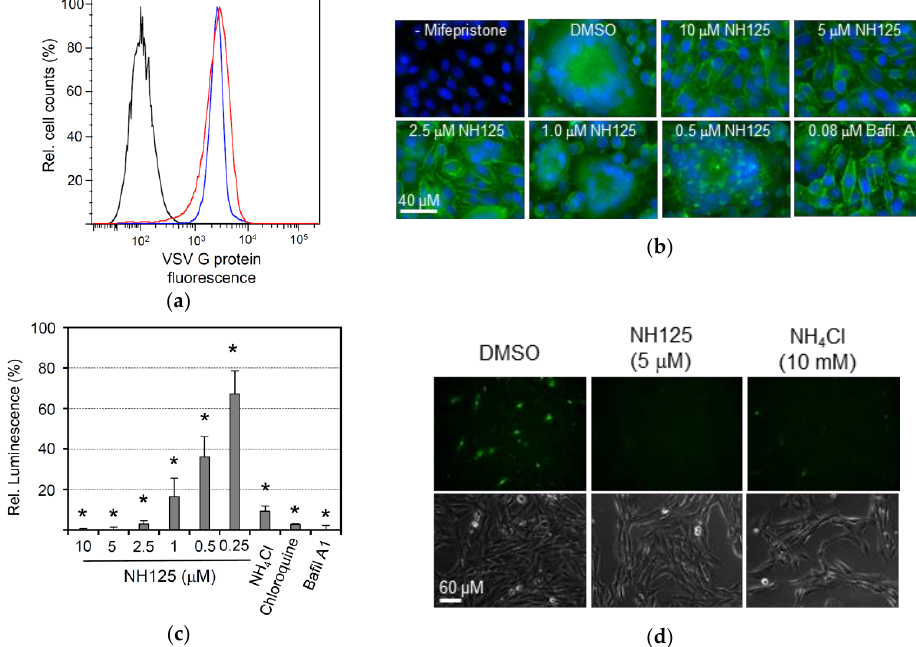
Figure 5. NH125 inhibits VSV G protein-mediated pH-dependent membrane fusion. ( a ) Flow cytometric analysis of VSV G protein cell surface expression in the presence of NH125. BHK-G43 cells were treated with mifepristone to induce VSV G protein expression and maintained for 16 h in the presence of either DMSO (red line) or 10 µM of NH125 (blue line). VSV G protein expression was detected at the cell surface using monoclonal antibody I1 and anti-mouse IgG AlexaFluor-488 conjugate. Non-induced BHK-G43 cells served as a negative control (black line). ( b ) VSV G protein-mediated syncytia formation. BHK-G43 cells were grown on 12-mm glass coverslips. When the cells were grown to confluence, the medium was replaced with fresh medium containing NH125 at the indicated concentrations and mifepristone to induce VSV G protein expression. At 24 h post induction, the cells were fixed with paraformaldehyde and VSV glycoprotein detected by indirect